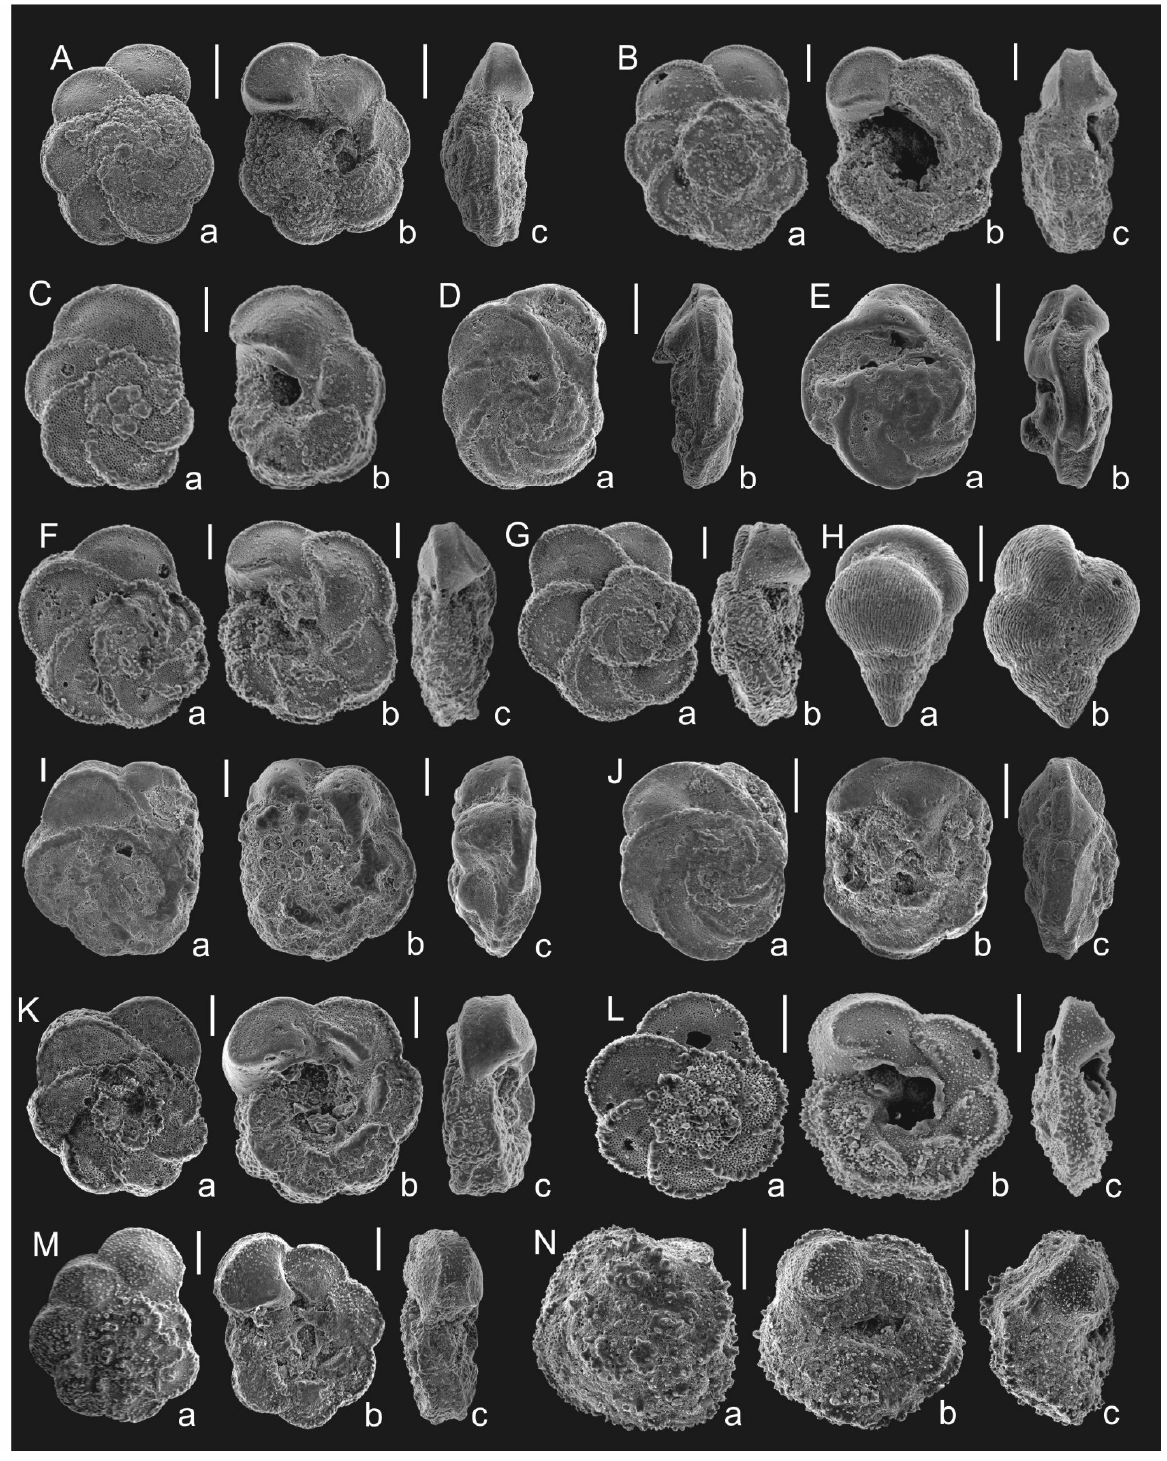
Figure 6. Planktonic foraminifera from the Dubivtsi 1 quarry ( A ), Słupia Nadbrzeżna outcrop ( B – G ), Ciszyca Górna ( H ), Dubivtsi 2 quarry ( I – K , M ) and Polanówka UW-1 borehole ( L , N ); A ( a – c ). Marginotruncana coronata ; B ( a – c ). Marginotruncana marginata ; C ( a , b ). Marginotruncana caronae ; D ( a , b ), E ( a , b ). Marginotruncana sinuosa ; F ( a – c ). Marginotruncana renzi ; G ( a , b ). Marginotruncana pseudolinneiana ; H ( a , b ). Pseudotextularia nuttali ; I ( a – c ). Marginotruncana paraconcavata ; J ( a – c ). Marginotruncana undulata ; K ( a – c ). Globotruncana linneiana ; L ( a – c ). Globotruncana arca ; M ( a – c ). Globotruncana bulloides ; N ( a – c ). Contusotruncana patelliformis . Scale bar = 100 µ